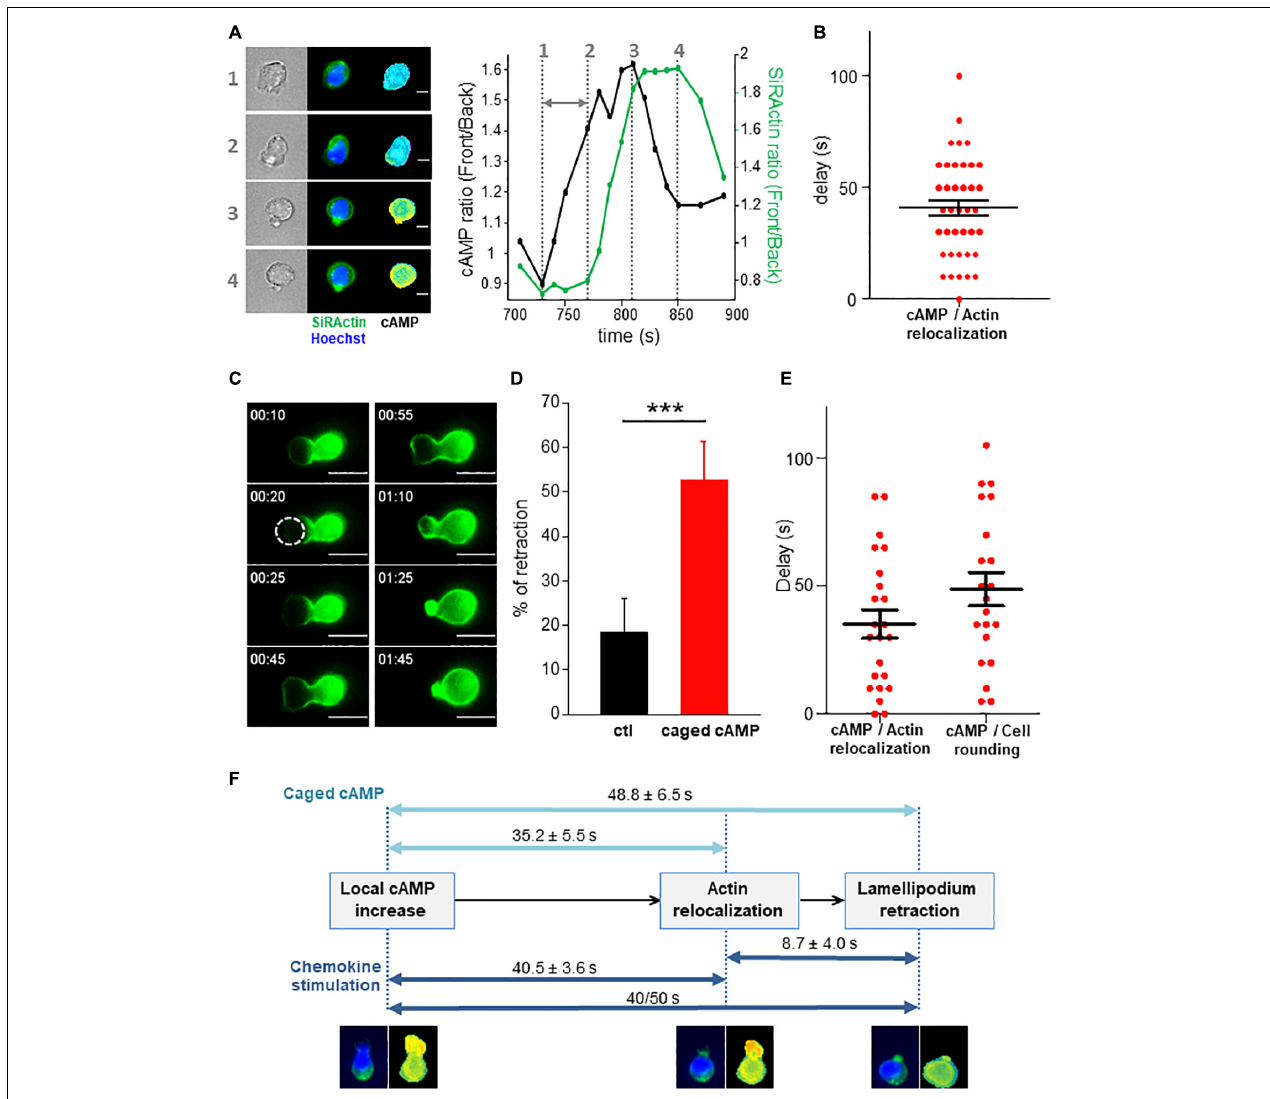
FIGURE 5 | cAMP increase drives stable actin relocalization. (A) Example of stable actin distribution recorded simultaneously with cAMP variations. The quantification of the two events is shown on the graph and the delay between the two is indicated by the gray arrow. The numbers show the times of the 4 steps. The complete series of images is shown in Supplementary Movie 7 . Scale bar = 10 µ m. (B) Delays between the beginning of cAMP increase and SiRActin relocalization measured as shown in (A). Values correspond to the mean ± SE of delays corresponding to 39 retraction events from 21 different cells. (C) Example of rounding up and actin relocalization induced by local release of cAMP after illumination at 405 nm. The cell was incubated previously with DMACM-caged 8-Br-cAMP and labeled with SiRActin. The size of the laser spot is indicated by the white circle. The complete series of images is shown in Supplementary Movie 8 . Scale bar = 10 µ m. (D) For each experiment, the frequency of lamellipodium retraction taking place within 2 min after illumination was quantified in cells pre-incubated with DMSO (ctl) or caged cAMP. Values correspond to the mean of nine independent experiments (6–21 cells/experiments). *** p < 0.001 paired t -test. (E) The delay between cAMP release and stable actin relocalization or increase of the roundness value was measured. For each cell, relocalization of SiRActin was measured over time as well as the roundness. The delay corresponds to the moment at which the values start to increase. Values correspond to the mean ± SE of 23 cells for actin relocalization and 21 for the roundness. (F) Summary of the three sequential steps leading to cell rounding: local increase in cAMP, recruitment of stable actin at the cell front cell, retraction of the lamellipodium leading to the rounding up of the cells. The delays measured in the different experiments are indicated. Dark blue: observation of migrating cells, light blue: artificial increase of cAMP induced by local photo-release of